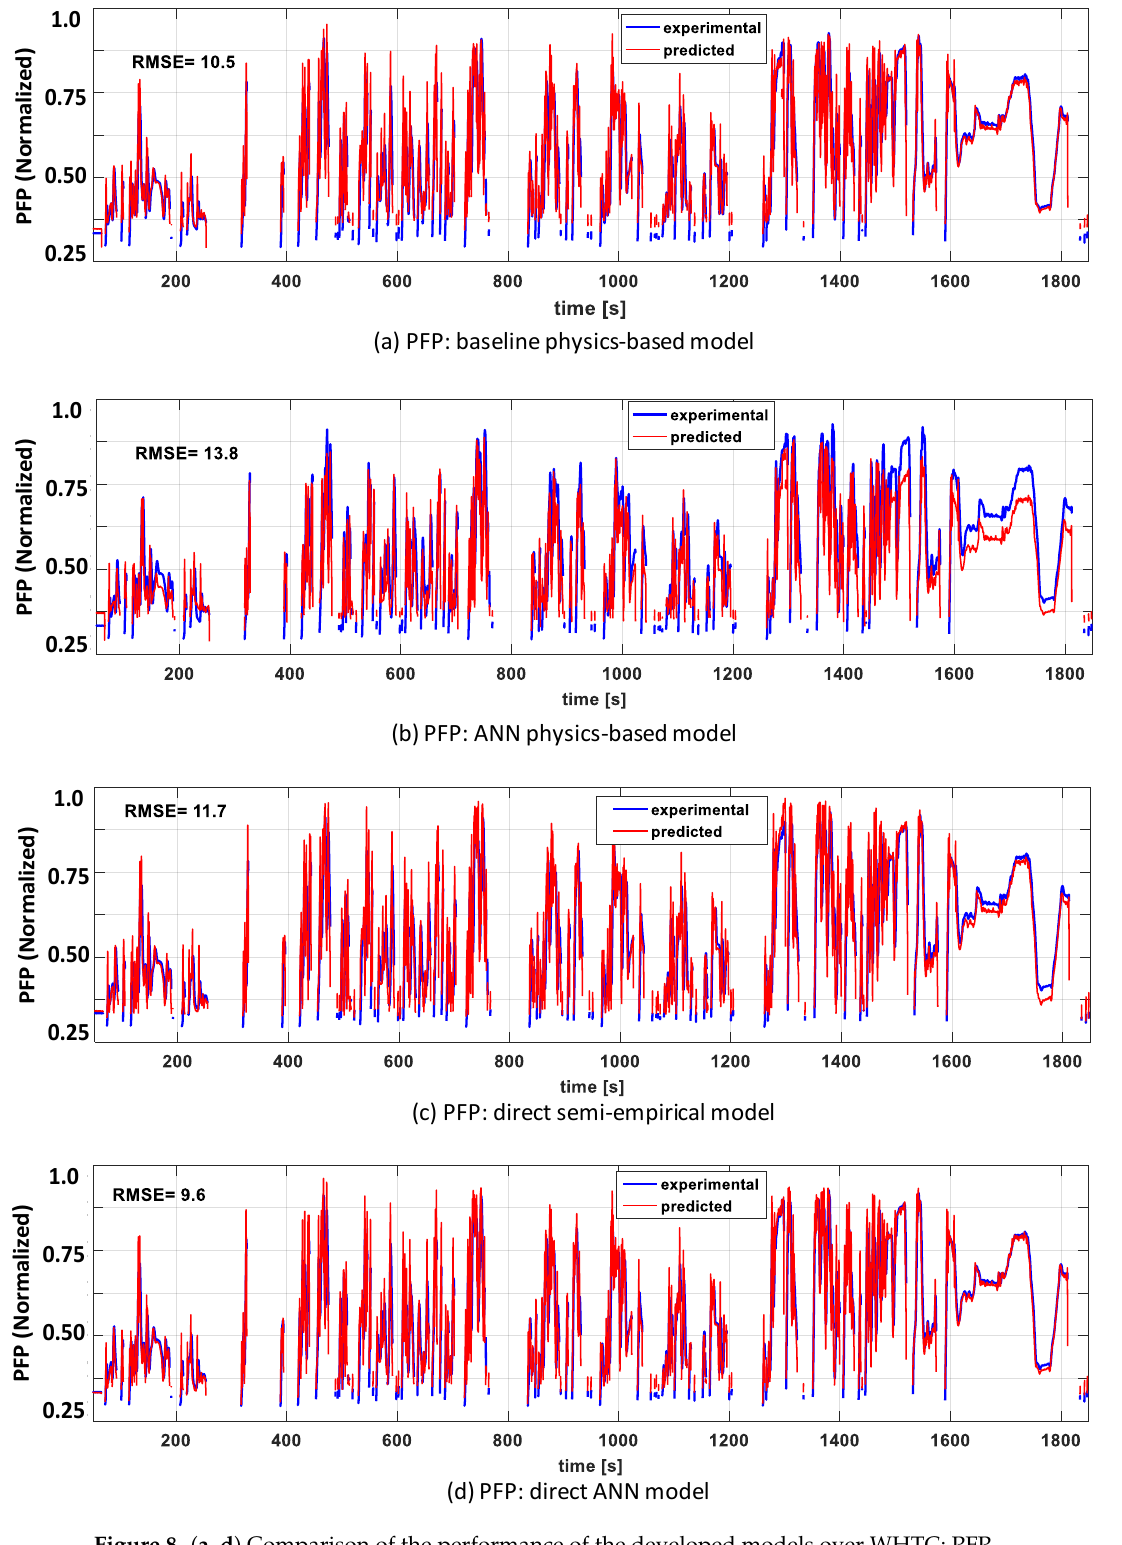
Figure 8. ( a – d ) Comparison of the performance of the developed models over WHTC: PFP.